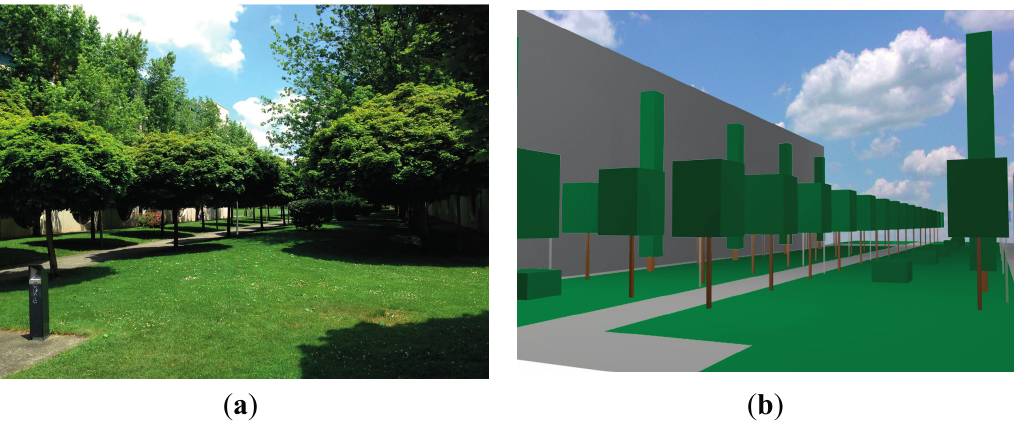
Figure 3. Vegetation scenario under consideration for simulation in the 3D Ray Launching algorithm ( a ) Real view ( b ) Schematic view for